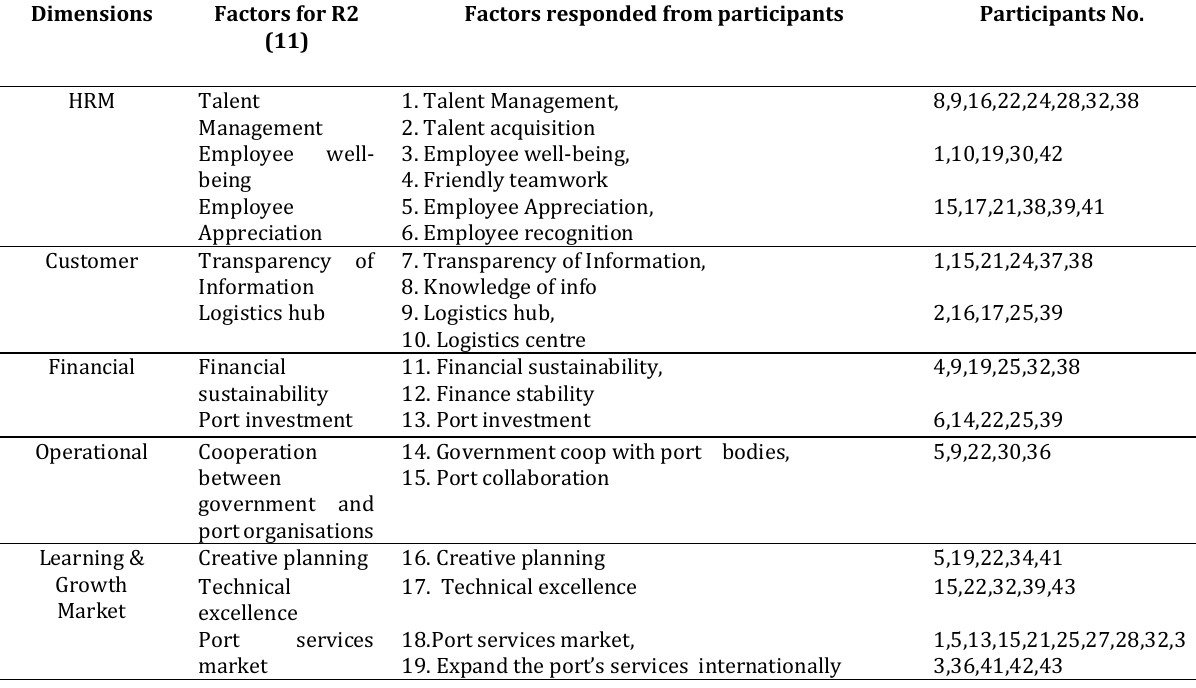
Table 4: 11 Newly explored factors